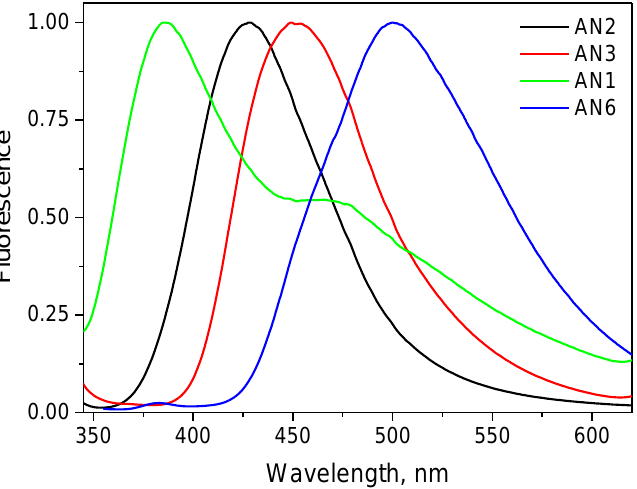
Figure 2. Normalized fluorescence spectra of selected compounds recorded in anhydrous ethanol at RT showing the influence of the dye structure on the position of the fluorescence band; Ex = 325